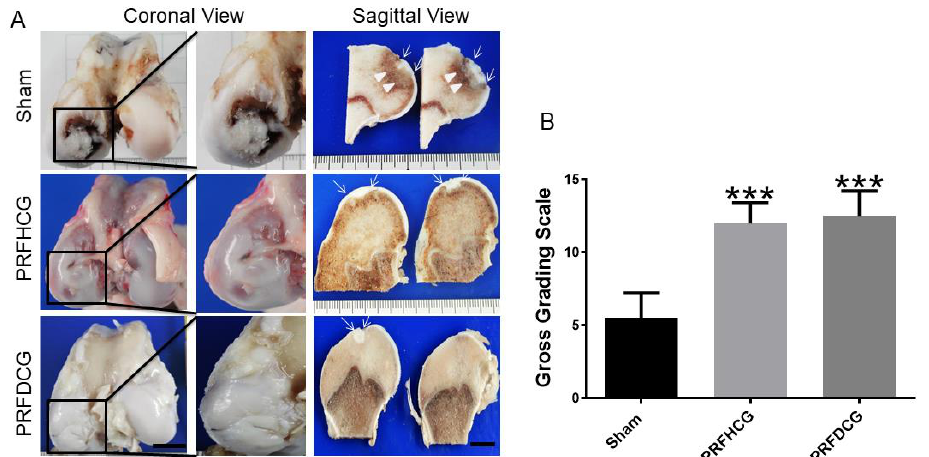
Figure 4. Gross view and grading scale of repaired regions: ( A ) Macroscopic coronal (left column) and sagittal (right column) views of representative defects from each of three experimental groups at 6 months (scale bar: 10 mm). Insets show magnified coronal views of the cartilage defect regions of representative specimens from each group and ( B ) detailed quantitative gross grading scale. The bars indicate the mean ± standard deviation ( n = 4) for each group. *** p < 0.001. PRFHCG, platelet-rich fibrin with hand-diced cartilage grafts and PRFDCG, platelet-rich fibrin with device-diced cartilage grafts.